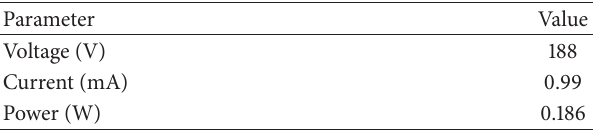
Table 9: Total power generation